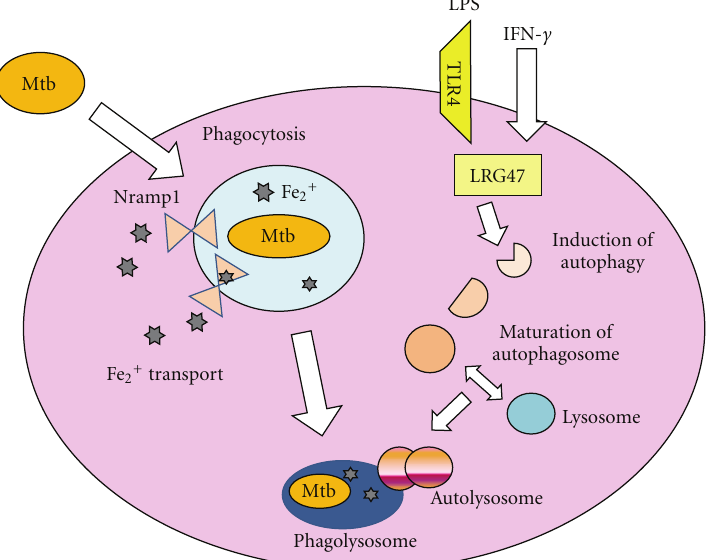
Figure 4: E ff ectors that mediate mycobacterial killing in macrophages. Macrophages eliminate invading mycobacteria by activating several e ff ector functions, such as phagosomes and autophagy. Nramp1 is expressed in the phagosomal membrane and presumably mediates mycobacterial killing by sequestering iron uptake. IFN- γ and the TLR4 ligand induce expression of LRG47, which in turn stimulates autophagy in macrophages. Autophagy is responsible for mycobacterial killing by promoting fusion of mycobacterial phagosomes to